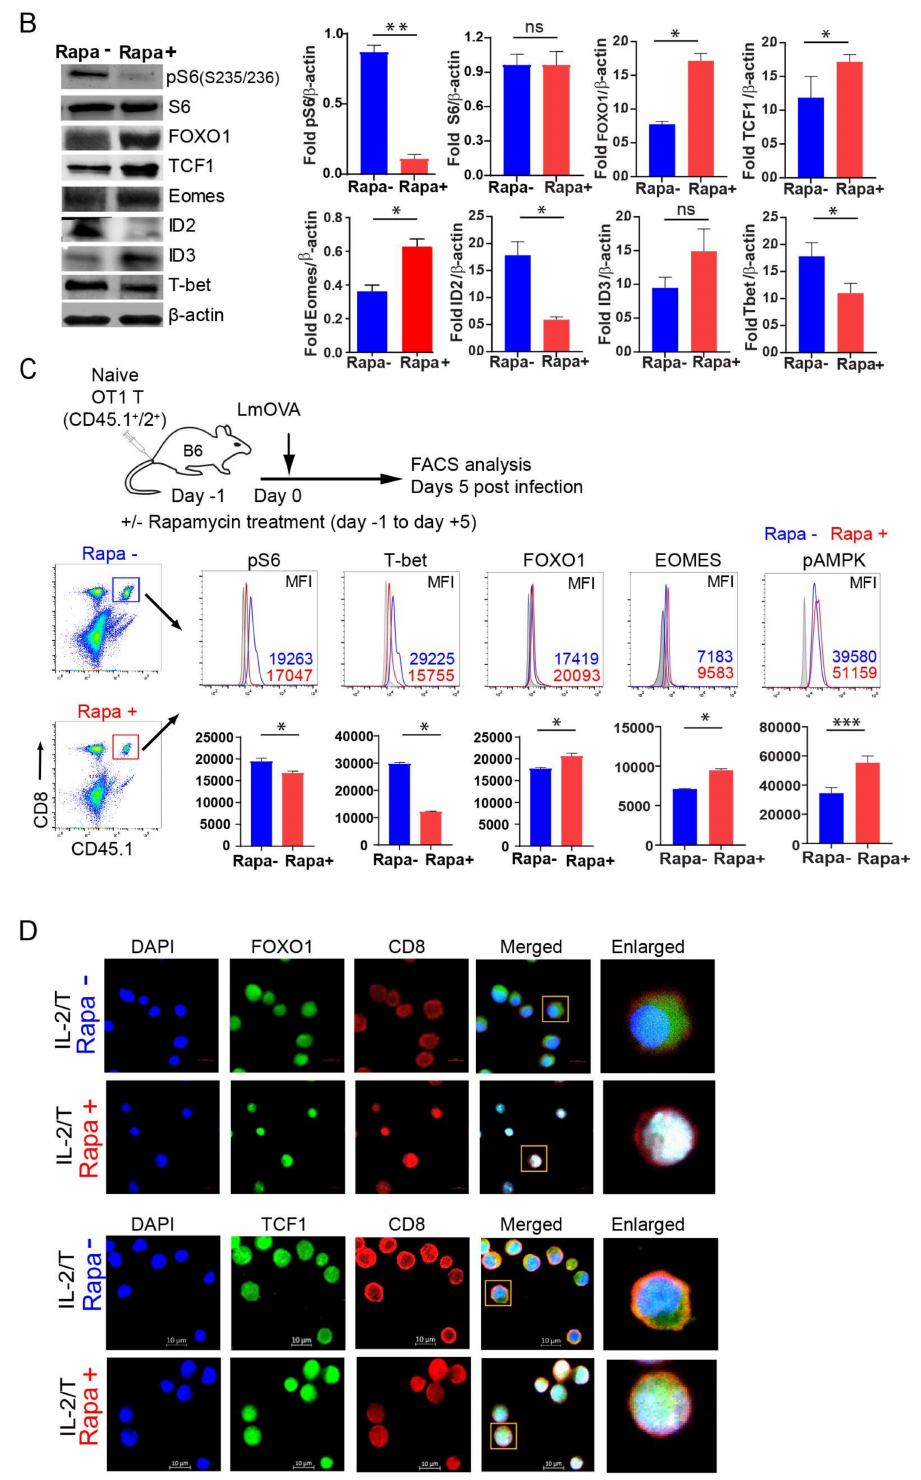
Figure 3. IL-2(Rapa+)/T-cells activate transcriptional FOXO1-TCF1-Eomes pathway. ( A ) Schematic diagram indicates splenic CD8 + T-cell culture using OT-1 mice (CD45.1 + /2 + ) to generate rapamycin- treated or not treated T-cells. CD8 + T-cells were activated by 0.1 nM OVAI-peptide in IL-2 containing media for 3 days. Following the wash, activated T-cells were treated or not treated with rapamycin (100 nM) in IL-2 containing media for 2 additional days to form IL-2/T E and IL-2(Rapa+)/T M cells. ( B ) IL-2/T E and IL-2(Rapa+)/T M cells were used to prepare cell lysates for the Western blot analysis (left panels). Bar diagrams indicate relative fold change expression of various molecules compared to b-actin loading control. ( C ) Schematic diagram indicates adoptive transfer of naïve